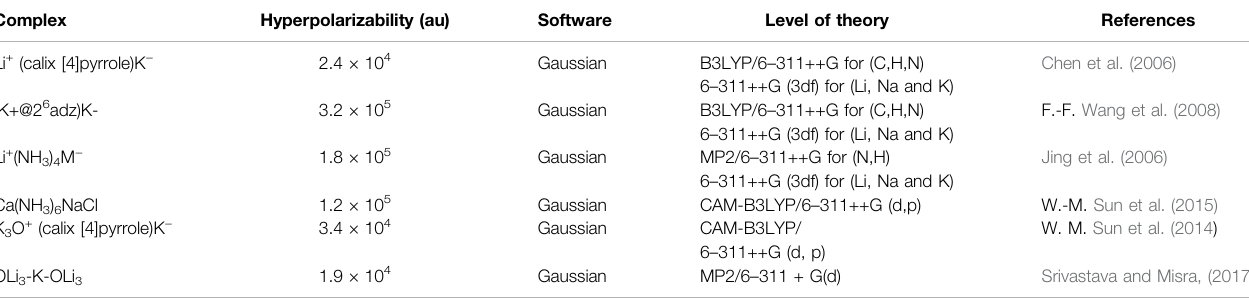
TABLE 2 | Nonlinear optical response (hyperpolarizability) of excess electron based alkalide complexes.